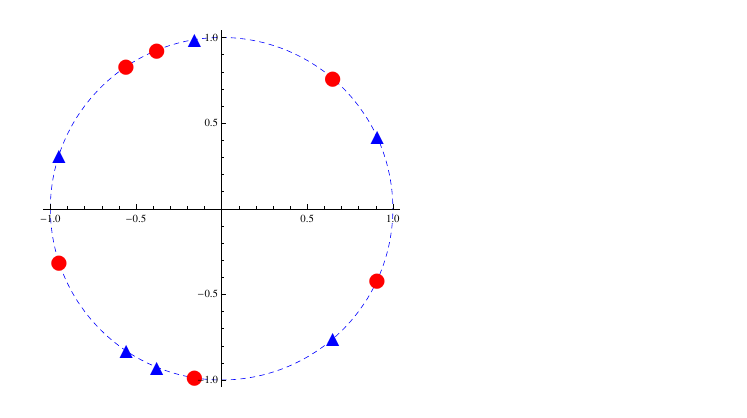
Figure 9 . The eigenvalues of tr F (cid:10) for su (3) with two (200) and three adjoint fermions. This theory has two degenerate vacua, which are labeled by distinct colors and markers. We (cid:12)nd tr F (cid:10) = (cid:0) 0 : 487 (cid:6) 0 : 798 I for the red (circle) and blue (triangle) vacua, respectively. The two vacua break C , P , and T , and therefore CPT